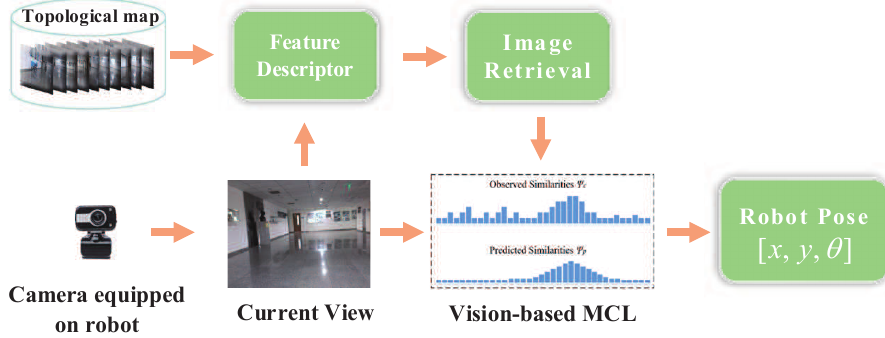
Figure 1. Architecture of